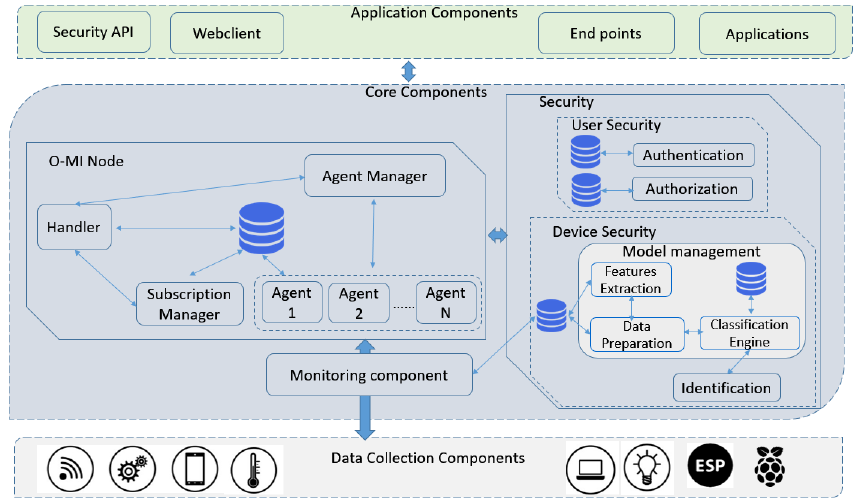
Figure 6. Service components over